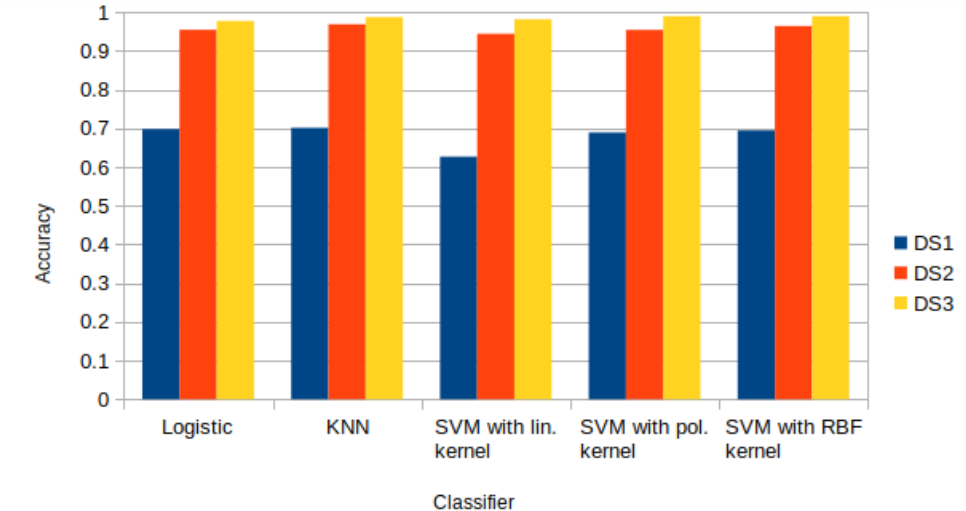
Figure 5. Comparison of the classification models used in [49] with the datasets DS1 (without any processing), DS2 (after aggregation and preprocessing), and DS3 (after normalization with weight